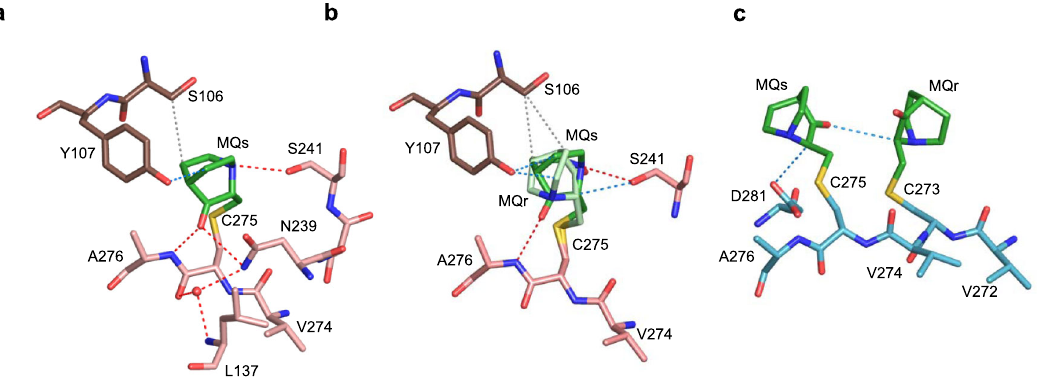
Fig. 3 MQ bound to C275 in R273H and R273C mutants. The MQ-C275 conjugates and intra- and intermolecular interactions are from the following crystal structures. a R273H-MQ (I), monomer A and symmetry-related monomer B. b R273H-MQ (I), monomer D and symmetry-related monomer C. c R273C-MQ (I), monomer C. Two alternative Cys-bound MQ enantiomers are shown in ( b ) (MQr in light green and MQs in dark green). MQ-C275 in the structure of R273C-MQ (I) is close to the nearby MQ-C273 conjugate. Other structure representations and color codes are as in Figs. 1, 2. sites are contiguous via either covalent linkage or base-pair stacking interactions within a continuous 20 bp DNA helix, except for wt- DNA-MQ (P1) where the two half-sites are separated by two stacked base pairs simulating a 22-bp helix (schematic DNA helices of the various complexes are in Supplementary Table 10).